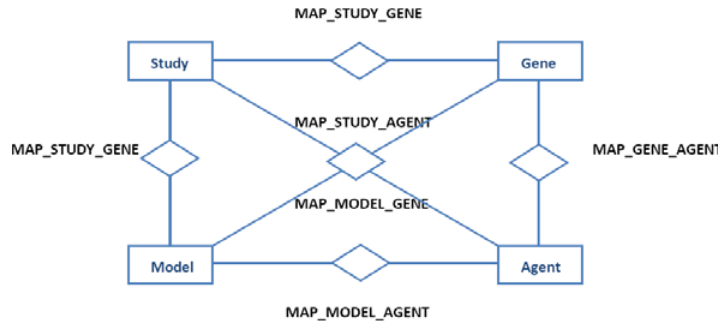
Figure 6: Solr used